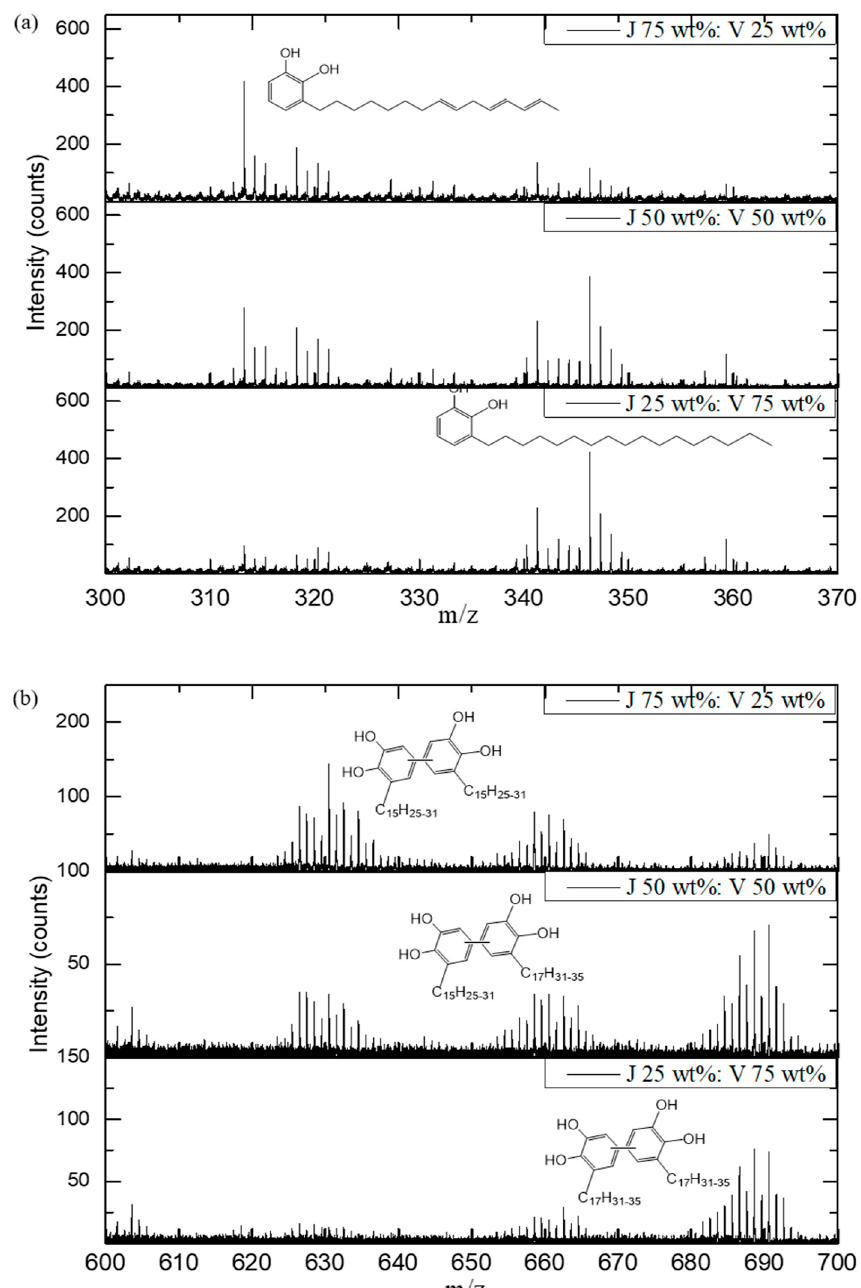
Figure 1. Positive-ion ToF–SIMS mass spectra of blended lacquer films of Japanese Toxicodendron vernicifluum and Vietnamese T. succedaneum in the following mass ranges: ( a ) m/z = 300 − 370; ( b ) m/z = 600 − 700.